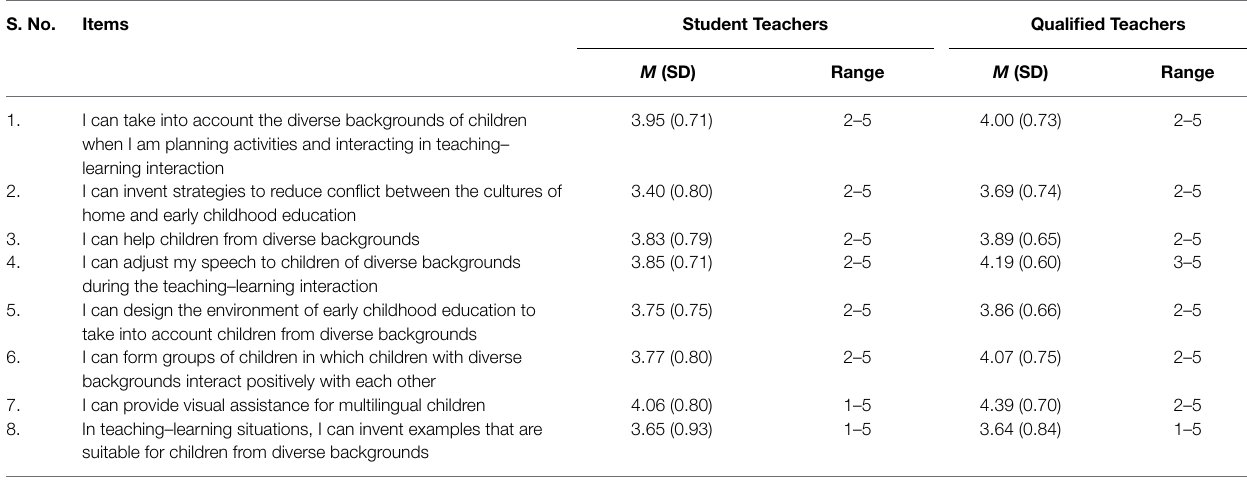
TABLE 1 | Culturally Inclusive Pedagogy scale items: descriptive statistics and reliability